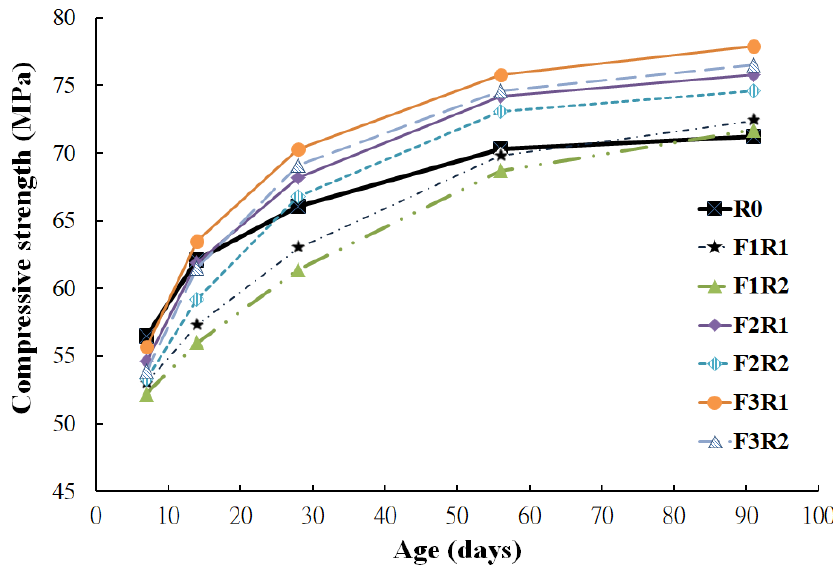
Figure 3. Compressive strength development for cylindrical specimens.